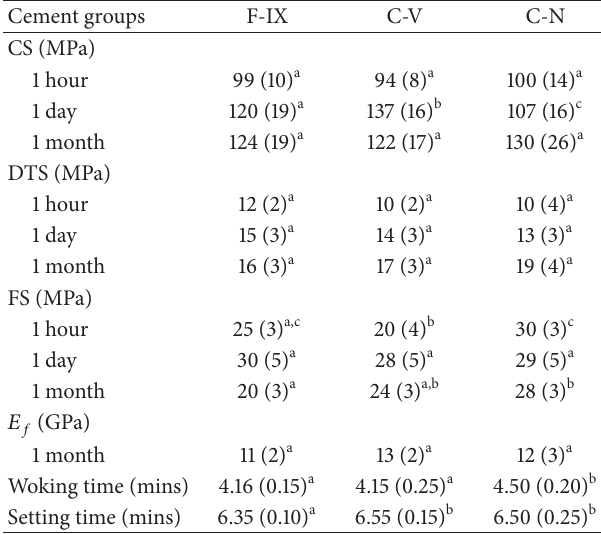
Table 2: Mechanical properties (CS, DTS, FS, and 𝐸 𝑓 ) results of experimental (nanoclay-reinforced GIC) and control group (Fuji- IX) GICs at different storage time. Mean values (standard deviation) of working time and setting time of cements are also